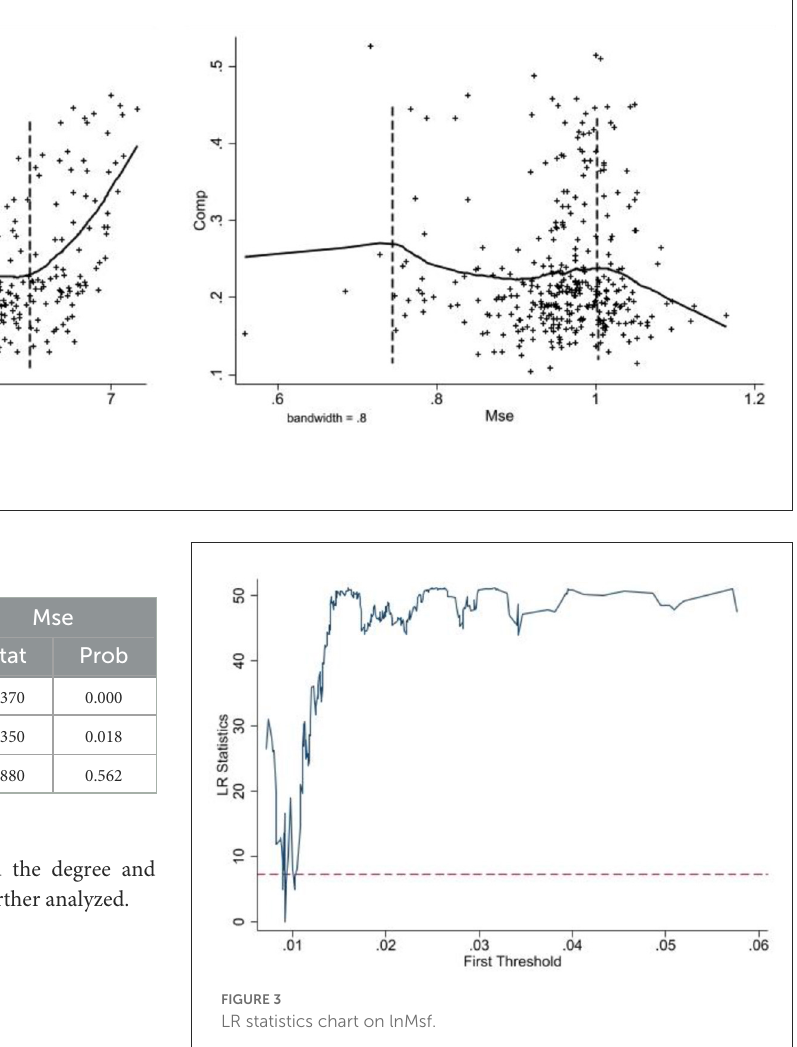
FIGURE3 LR statistics chart on